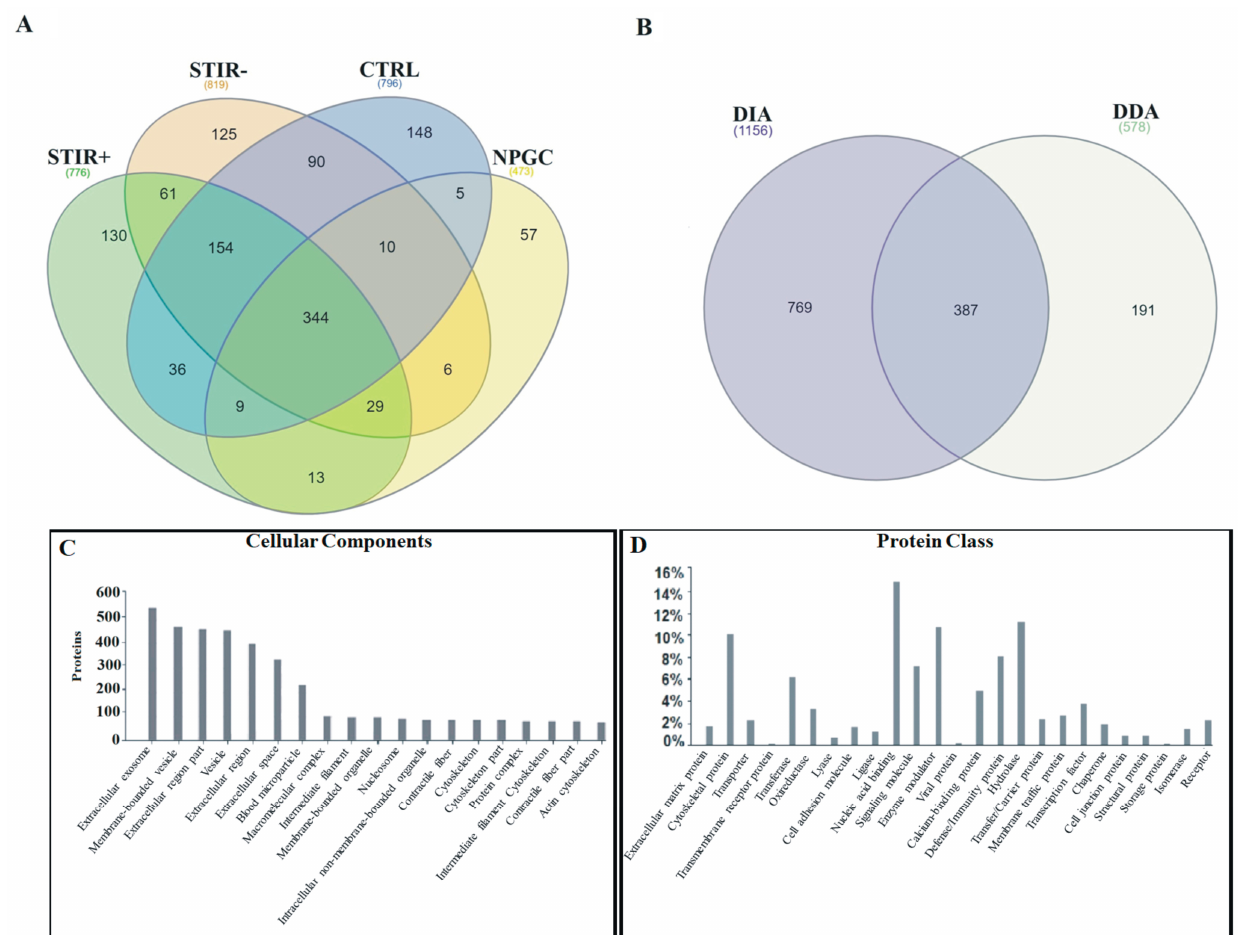
Figure 3. Identified proteins and Gene Ontology analysis. ( A ) Venn diagram of all the proteins identified in DIA in the examined conditions. ( B ) Overlap between proteins identified with the Synapt G2Si (DIA) and Orbitrap Elite (DDA) mass spectrometers. ( C ) PANTHER Gene Ontology analysis showing the cellular components to which the identified proteins belong. ( D ) PANTHER Gene Ontology analysis showing the class distribution of the identified proteins.